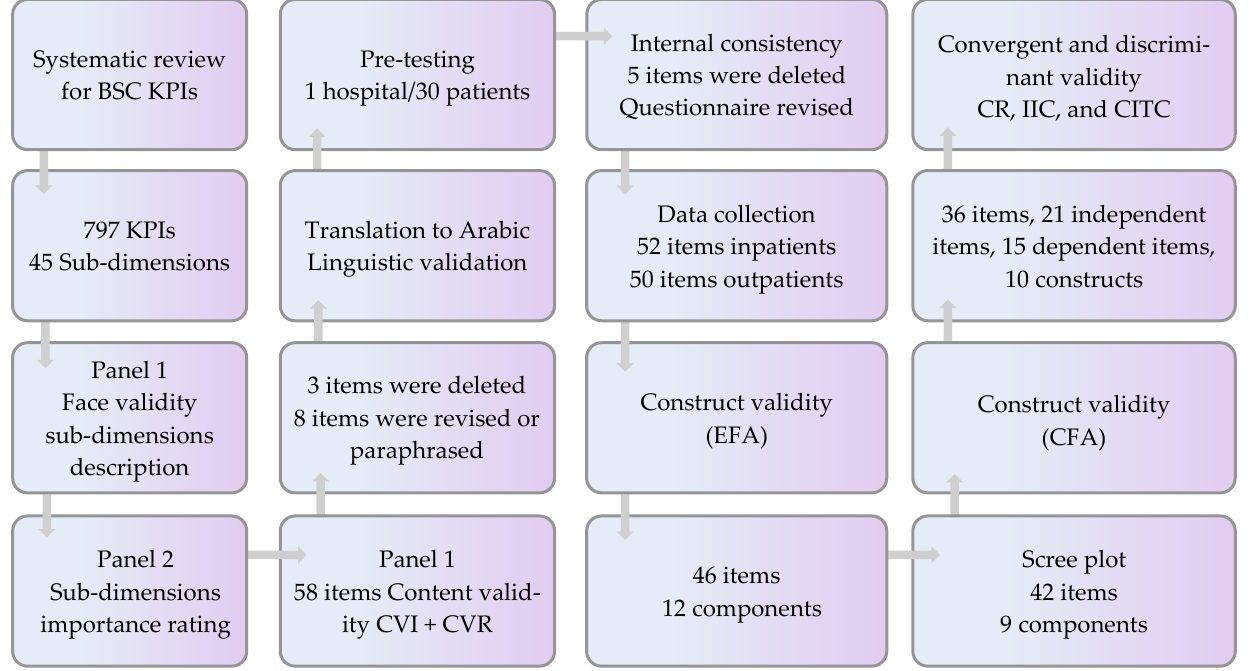
Figure 5. Flow chart for BSC-PATIENT development and psychometric validation.